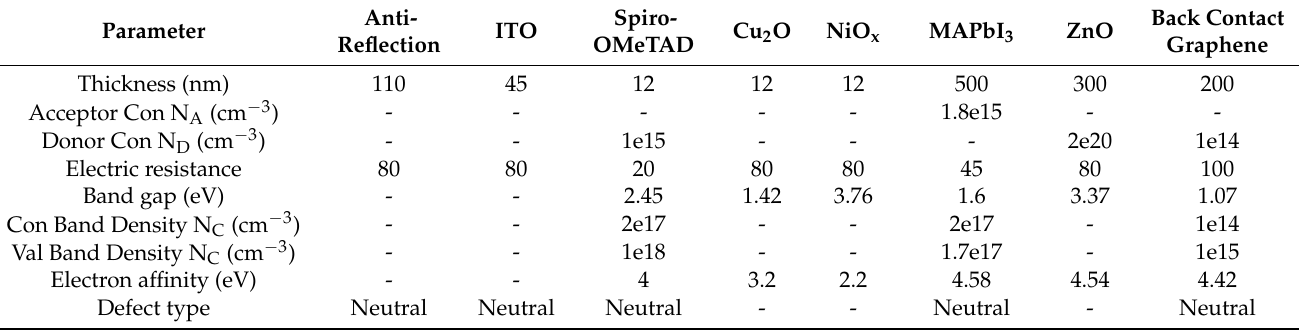
Figure 3. Energy band graph of the proposed solar cell. Table 1. Electrical parameters used to simulate the inverted planar